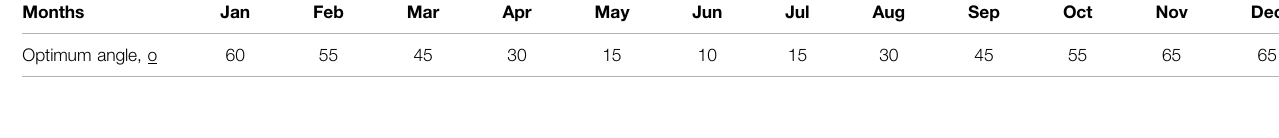
TABLE 1 | Optimal angle of inclination of the solar collector in different periods of its use in Poland (Kreft et al., 2020). Months Jan Feb Optimum angle, o